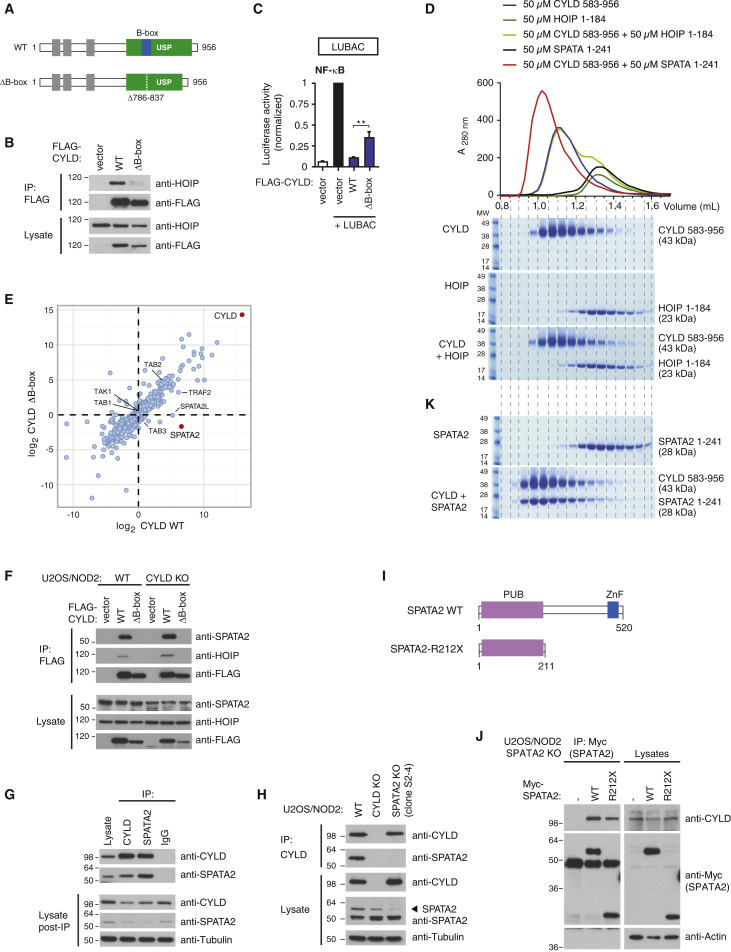
Identification of SPATA2 as a B-box-Dependent CYLD Interactor(A) Schematic representation of full-length and ΔB-box (deletion of aa residues 786–837) CYLD.(B) Immunoprecipitation and western blot analysis of transiently expressed FLAG-CYLD variants from CYLD KO U2OS/NOD2 cells.(C) NF-κB activity in U2OS/NOD2 cell lysates transfected with dual luciferase reporters and co-expressed with vector, LUBAC (HOIL-1/HOIP), and/or FLAG-CYLD variants as indicated. Luciferase activity is shown relative to the activity of LUBAC in transfected cells. Data represent the mean ± SEM of six independent experiments, each performed in duplicate. ∗∗p < 0.01.(D) Analytical SEC profile of CYLD USP (583–956) (blue), HOIP PUB domain (1–184) (green), and HOIP and CYLD at equimolar ratio (light green). Coomassie-stained SDS-PAGE gels below show protein-containing fractions. Also included are SPATA2 PUB domain (1–241) (black) and CYLD and SPATA2 at equimolar ratio (red) (see K).(E) Mass spectrometry analysis of FLAG-CYLD interactomes purified with anti-FLAG from CYLD KO U2OS cell lysates. The scatterplot shows enrichment of proteins co-purified with CYLD WT (x axis) and CYLD ΔB-box (y axis). Dots below the diagonal indicate B-box-dependent interactors.(F) Immunoprecipitation and western blot analysis of transiently expressed FLAG-CYLD variants from WT or CYLD KO U2OS/NOD2 cells.(G) Immunoprecipitation and western blot analysis of endogenous CYLD and SPATA2 from U2OS/NOD2 cells. Control IgG served as negative control.(H) Immunoprecipitation and western blot analysis of transiently expressed FLAG-CYLD from WT, CYLD KO, or SPATA2 KO (clone S2-4) U2OS/NOD2 cells.(I) Schematic representation of SPATA2 WT and SPATA2 R212X (SPATA2 aa 1–211).(J) Immunoprecipitation and western blot analysis of transiently expressed Myc-SPATA2 variants from SPATA2 KO U2OS/NOD2 cells.(K) Coomassie-stained SDS-PAGE gels (linked to profile in D) of SPATA2 PUB and CYLD USP-SPATA2 PUB complex.Also see Figure S1.